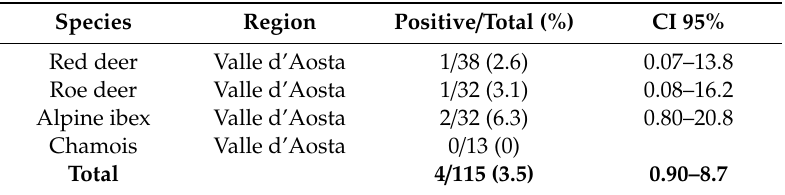
Table 2. Serological prevalence of HEV in wild